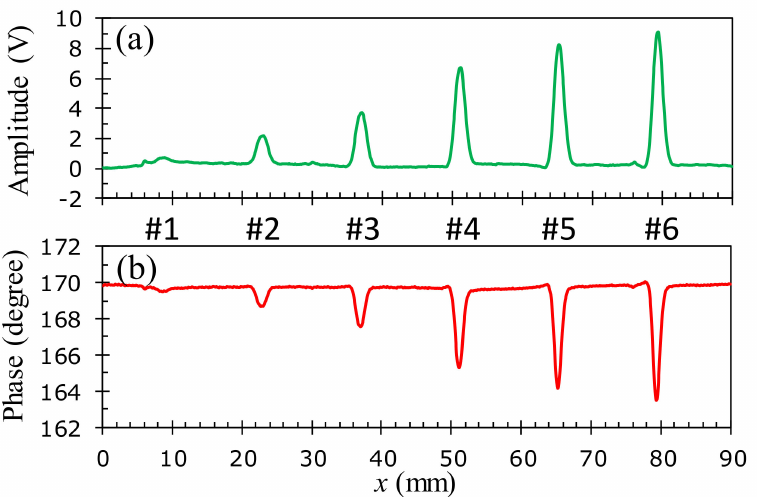
Figure 16. Inspection of surface cracks ( h = 0 mm) at the 45 kHz optimal excitation frequency on an aluminum specimen: ( a ) amplitude variation, ( b ) phase angle